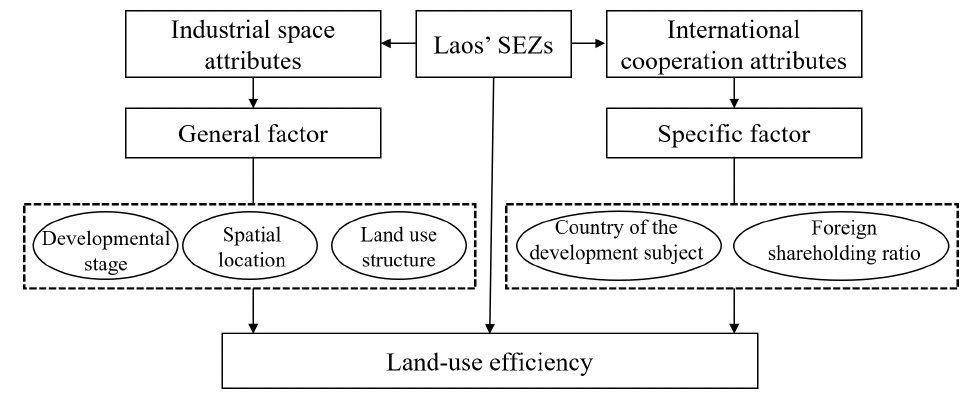
Figure 7. Land-use impact mechanism of Laos’ SEZs.